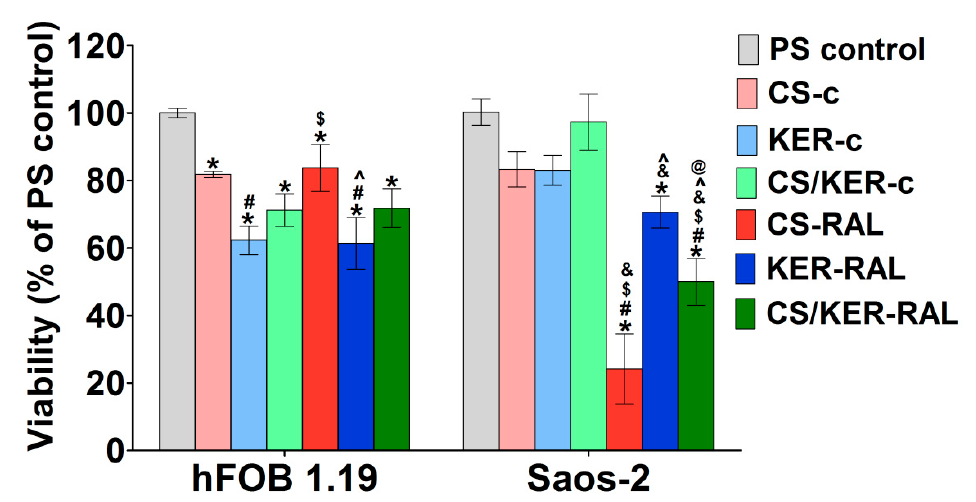
Figure 6. Evaluation of cell viability after 48-h exposure to granule extracts by MTT assay (hFOB 1.19—human normal osteoblasts; Saos-2—human tumor cells derived from osteosarcoma; PS control—polystyrene extract as a negative control of cytotoxicity; * statistically significant results compared to PS control, # statistically significant results compared to CS; $ statistically significant results compared to KER; & statistically significant results compared to CS/KER; ˆ statistically significant results compared to CS-RAL; @ statistically significant results compared to KER-RAL; p < 0.05, one-way ANOVA followed by Tukey’s test).